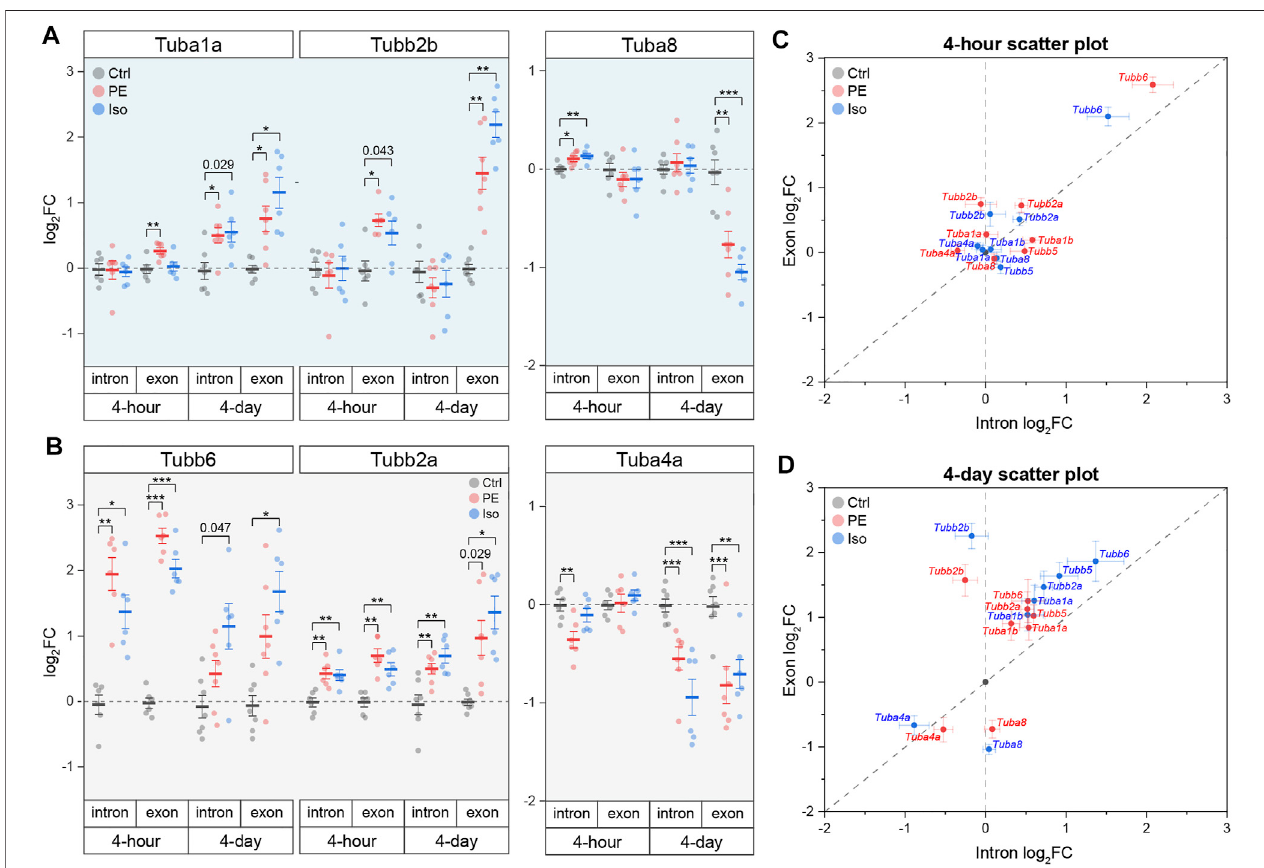
FIGURE6| TubulinisoformsaredifferentiallyregulatedatthemRNAlevel throughisoform-speci fi ctranscriptionand/or autoregulation during cardiac hypertrophy. Relativelog 2 fold-changeofmRNAcountsof αβ -tubulinisoformsthatarepredominantlyregulatedthrough (A) autoregulation,or (B) transcription(n=4 h:6,4 days:Ctrl: 7, PE:7, Iso:6); * represents p-value from Welch-corrected two-tailed two-sample t-test on non-log data < 0.025 (Bonferroni-corrected for two comparisons), ** represents p < 0.01, and *** represents p < 0.001. Scatter-plots of relative log 2 fold-change of intron on x-axis and exon on y-axis at (C) 4-h and (D) 4-days timepoints; whiskers represent ± 1SEM.